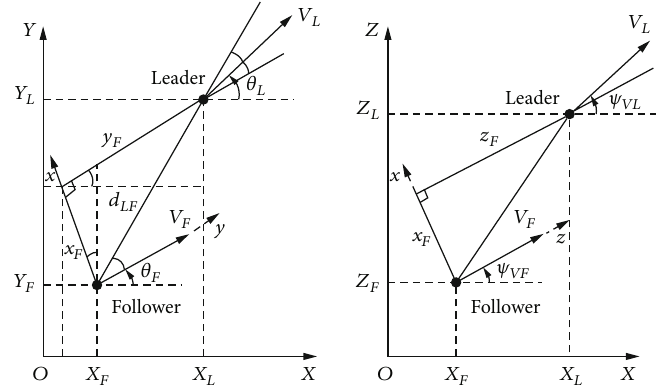
Figure 1: Relation between the leader and the follower ammunition in the inertial coordinate Table 1: Parameters of the leader and follower ammunition. Leader